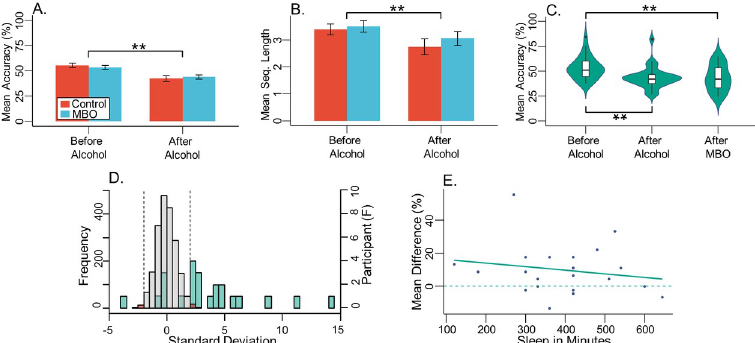
Fig 3. Serial recall. ( A ) bar graph shows between control and MBO group mean accuracy (%) of serial recalled words, both before and after ingesting alcohol. Error bars depict standard error of the mean, with �� denoting significance at p < .01, and � < .05. ( B ) shows the same as ( A ), except that mean accuracy (%) for sequence length, i.e., the average number of words recalled in sequence, is plotted. ( C ) violin plots show the distribution of MBO participant responses in the serial recall task for overall recall accuracy, with embedded box and whisker plots across all three test conditions ( before-alcohol , after-alcohol , after-MBO ). Outliers appear as dots above or below the box and whisker plots. ( D ) histograms depicting the resampling analysis for mean accuracy % in the serial recall task for the MBO group. The left y axis shows the frequency of resampled mean differences, converted into z-scores, between before-alcohol minus after- MBO conditions. Bar width is 0.5 standard deviations. Grey bars depict roughly 95% of the resampled distribution, and the red bars show the 2.5% tails at either side, demarcated by vertical dashed lines. Overlaid green bars are a separate histogram (right y axis) showing the frequency of participants’ mean differences (z-scores), with the same bar width of 0.5 standard deviations. ( E ) scatterplot displays the difference between the mean accuracy (%) for serial recalled words before-alcohol minus after-MBO , correlated with reported minutes slept, within the MBO